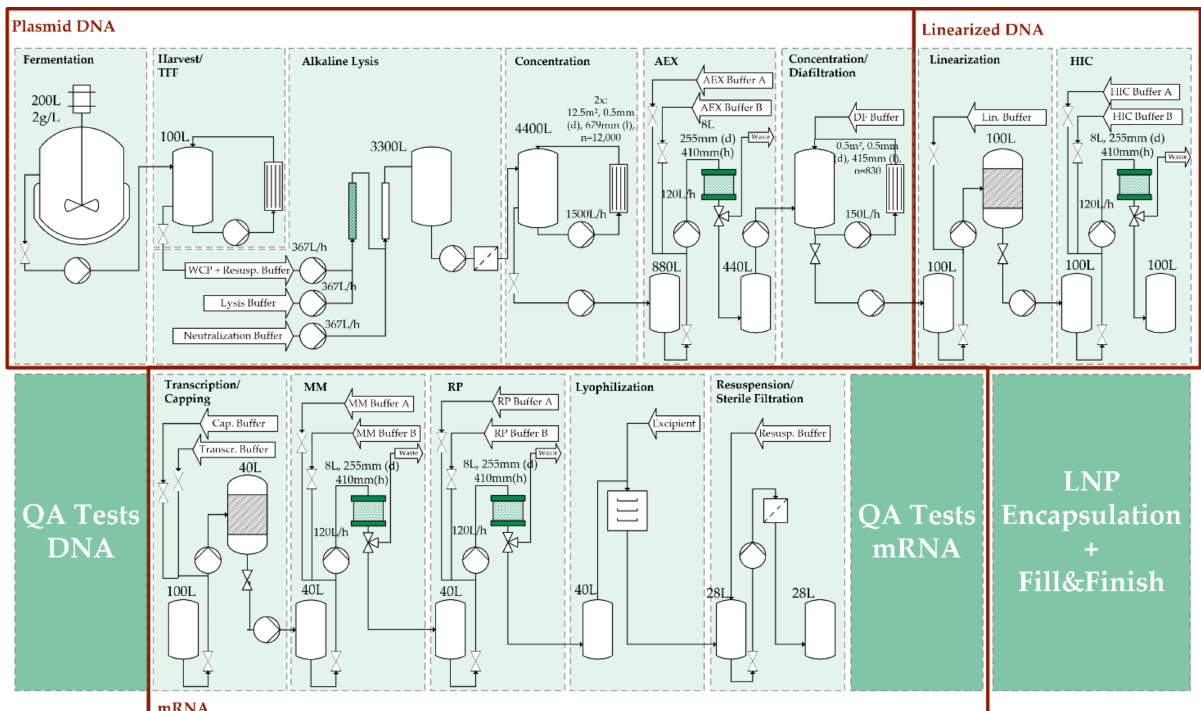
Figure 6. Overview of the plasmid production, quality testing and mRNA manufacturing process. The process consists of three main steps, which are plasmid production, linearization, and in-vitro transcription. After linearization and mRNA purification extensive quality testing is